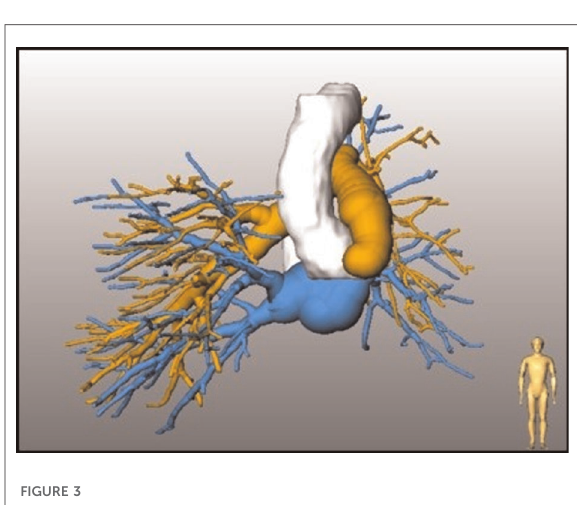
FIGURE 3 Pulmonary arteries and veins in relation to bronchial